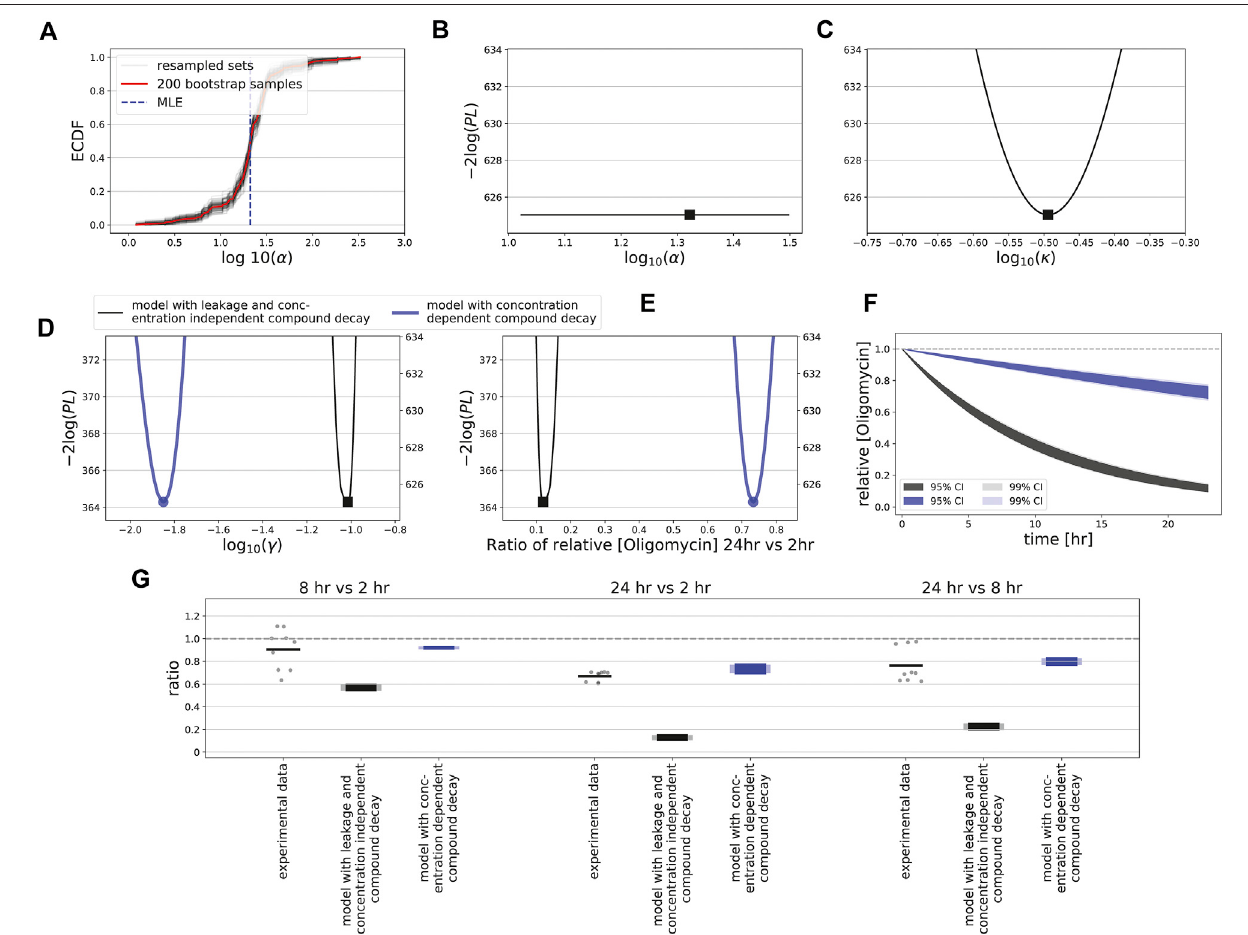
FIGURE 8 | Uncertainty quanti fi cation and measurements for oligomycin. (A) Empirically determined cumulative distribution function (ECDF) of the estimated α valuesforbootstrappeddata.RedlineshowsECDFbasedonall200bootstrap samples,gray linesshow 100resampled bootstrapsets (withreplacement),andvertical blue dashed line indicates the estimated MLE of the original data. (B) Pro fi le likelihood for the leakage rate ( α ), for the model with compound decay and ion leakage is utilized. (C, E) Pro fi le likelihoods for the ensemble of parameters affecting leakage and ion fl ux via complex V ( κ ; see Supplementary Text ) (C) , for the oligomycin degradation rate ( c ) (D) , and for the ratio of effective concentrations at 24 and 2 h (E) . (F) Model-predicted oligomycin dynamics within cells based on 95% (dark shadings) and 99% con fi dence interval (light shadings) of estimated c values, with pro fi le-likelihood-based CIs. In (C – F) either the model is utilized in which the structural unidenti fi ability of the leakage rate has been solved, with concentration-independent decay c (black), or in which decay does depend on the oligomycin concentration with c (cid:2) c H forhighconcentrations(blue). (G) Ratiosbetweentimepoints2,8and24 h(allpossiblecombinations)oftheLC-MS/MS-basedintracellularconcentrationsof oligomycinafterexposuretoaconcentrationof0.5 μ M(dotsindicateallpossiblevaluesoftheratiosbasedonseparatemeasurements,andbarsindicatethemeanofall these ratios) and of the model-based CIs for the ratios. The model-based CIs are based on the pro fi le likelihood analysis for a model with concentration-independent decay (black) or with concentration-dependent decay (blue), with the dark colours based on 95% CIs and light colours based on 99% CIs.